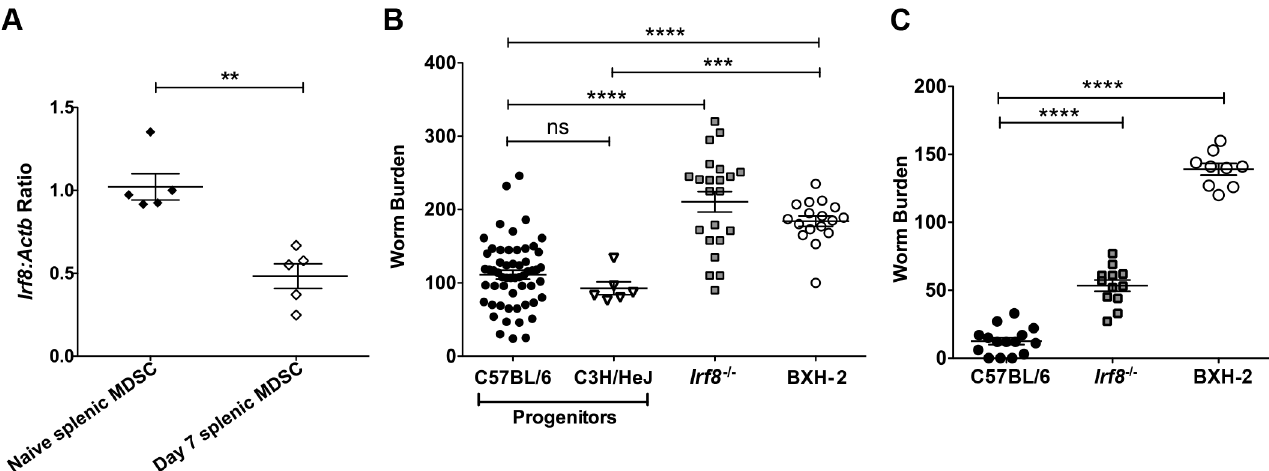
Fig 1. Irf8 expression is down-regulated in MDSC and contributes to higher worm burdens after Hpb infection. (A) Irf8 expressionin CD11b + Gr1 + cells purifiedfrom spleensof na ï veand infected C57BL/6(B6) mice on day 7 p.i. Each point represents cells pooledfrom 2 na ï vemice or one infected B6 mouse. Representative results of one of two replicate experiments are shown. Data are presentedas relative quantity of Irf8 normalized againstthe endogenouscontrol Actb . (B) Adult worm burdenafter primary Hpb infectionin WT B6 and progenitor C3H/HeJmice comparedto Irf8 -/- and IRF-8 deficientBXH-2 mice. The worm burdensof individualmice pooledfrom independent experiments are shown. (C) Adult worm burdenafter challenge Hpb infectionin WT B6, Irf8 -/- and BXH-2 mice. The worm burdensof individualmice pooledfrom independent experiments are shown. Data are presented as mean ± SEM. ns, not significant; ** , p (cid:20) 0.01; *** , p (cid:20) 0.001; **** , p (cid:20) 0.0001.